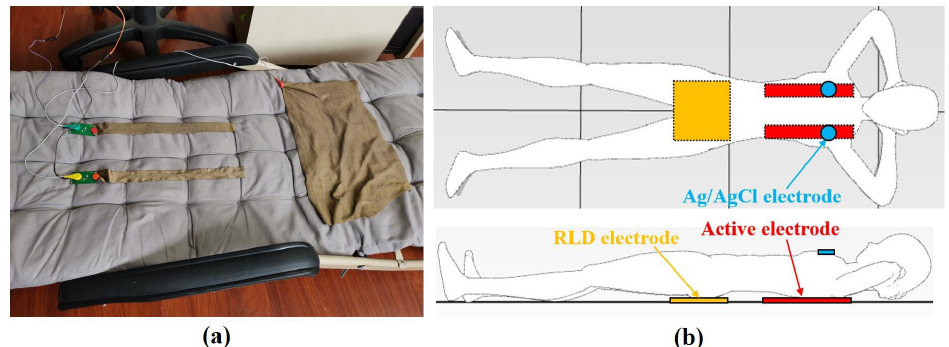
Figure 12. Experimental setups in lying supine posture: ( a ) picture, ( b )